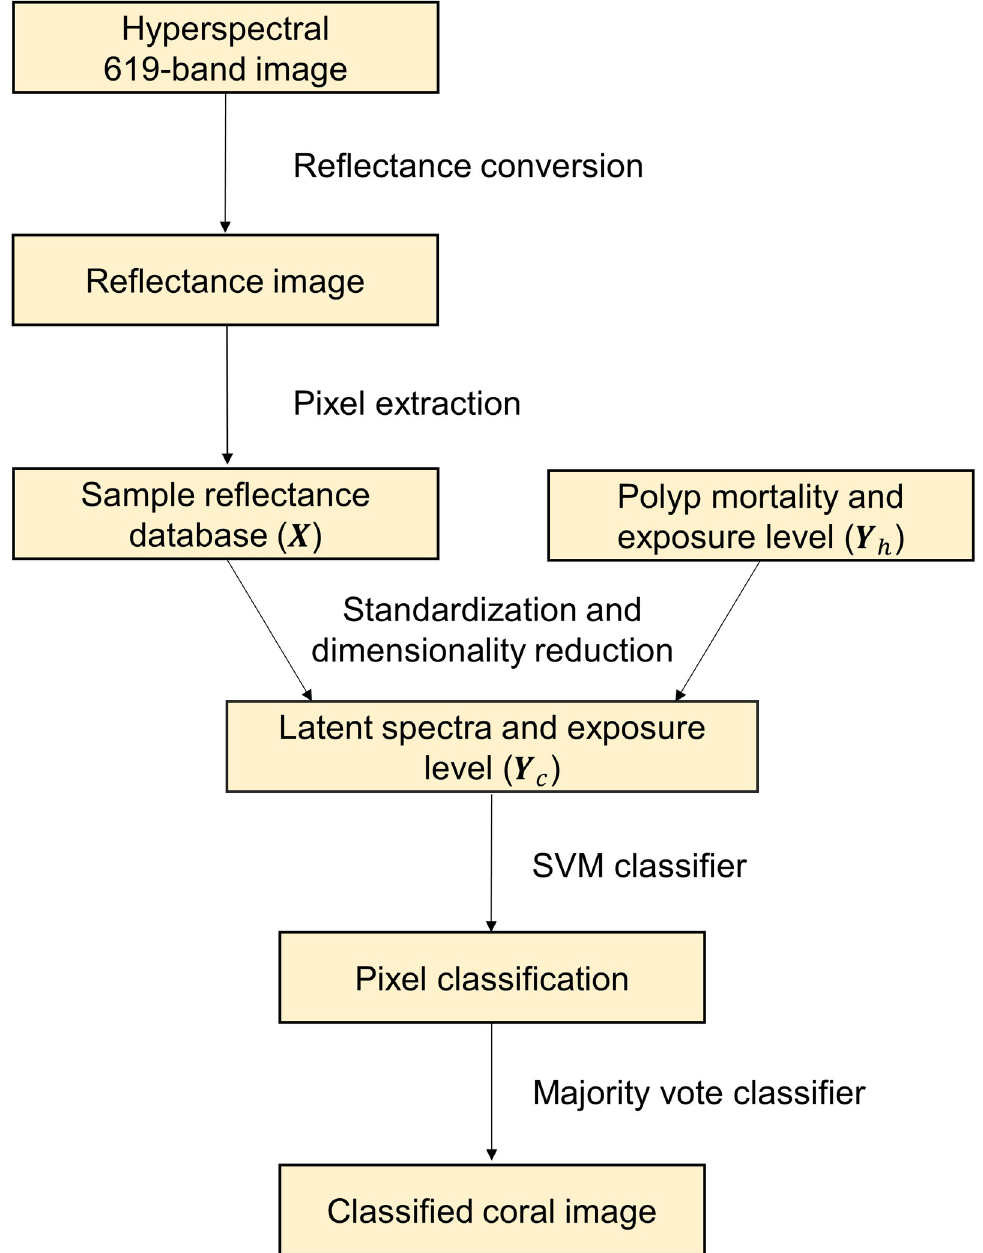
Fig 4. Data analysis flowchart. The flowchart shows the full data analysis pipeline including all steps of the classification model.